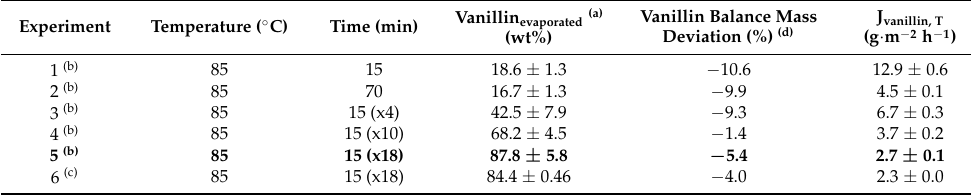
Table 10. Vacuum distillation with fractionated condensation: percentage of evaporated vanillin, mass balance deviation to vanillin and total vanillin